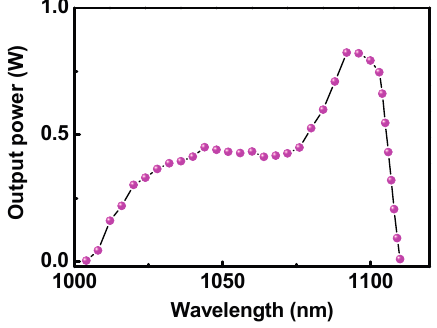
Figure 3. Wavelength tuning curve of the Yb:GYSO laser with a 0.8% transmission output coupler at 3.8 W pump